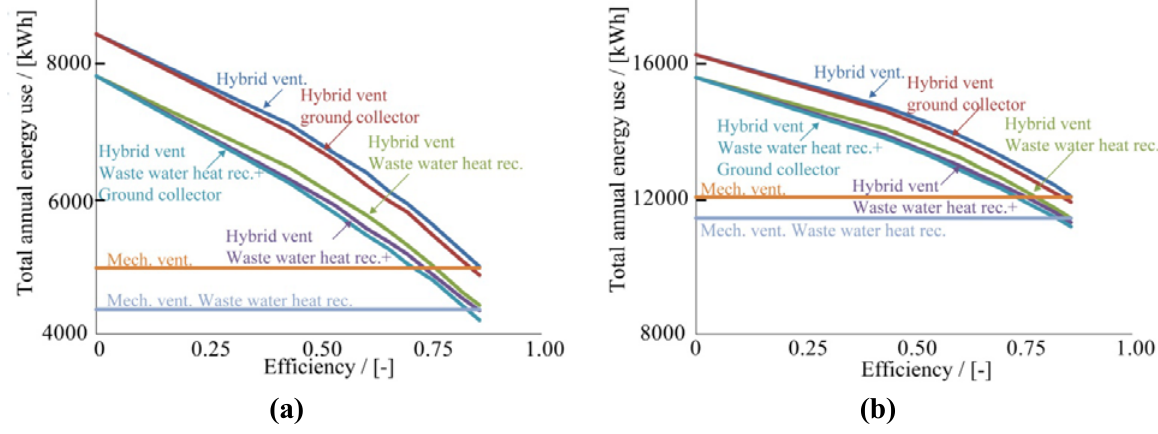
Figure 3. The total energy need, i.e. , space and domestic hot water heating, for the different simulations as a function of the efficiency of each of the heat exchangers for the ventilation. ( a ) is the low energy building; and ( b ) is the standard insulated